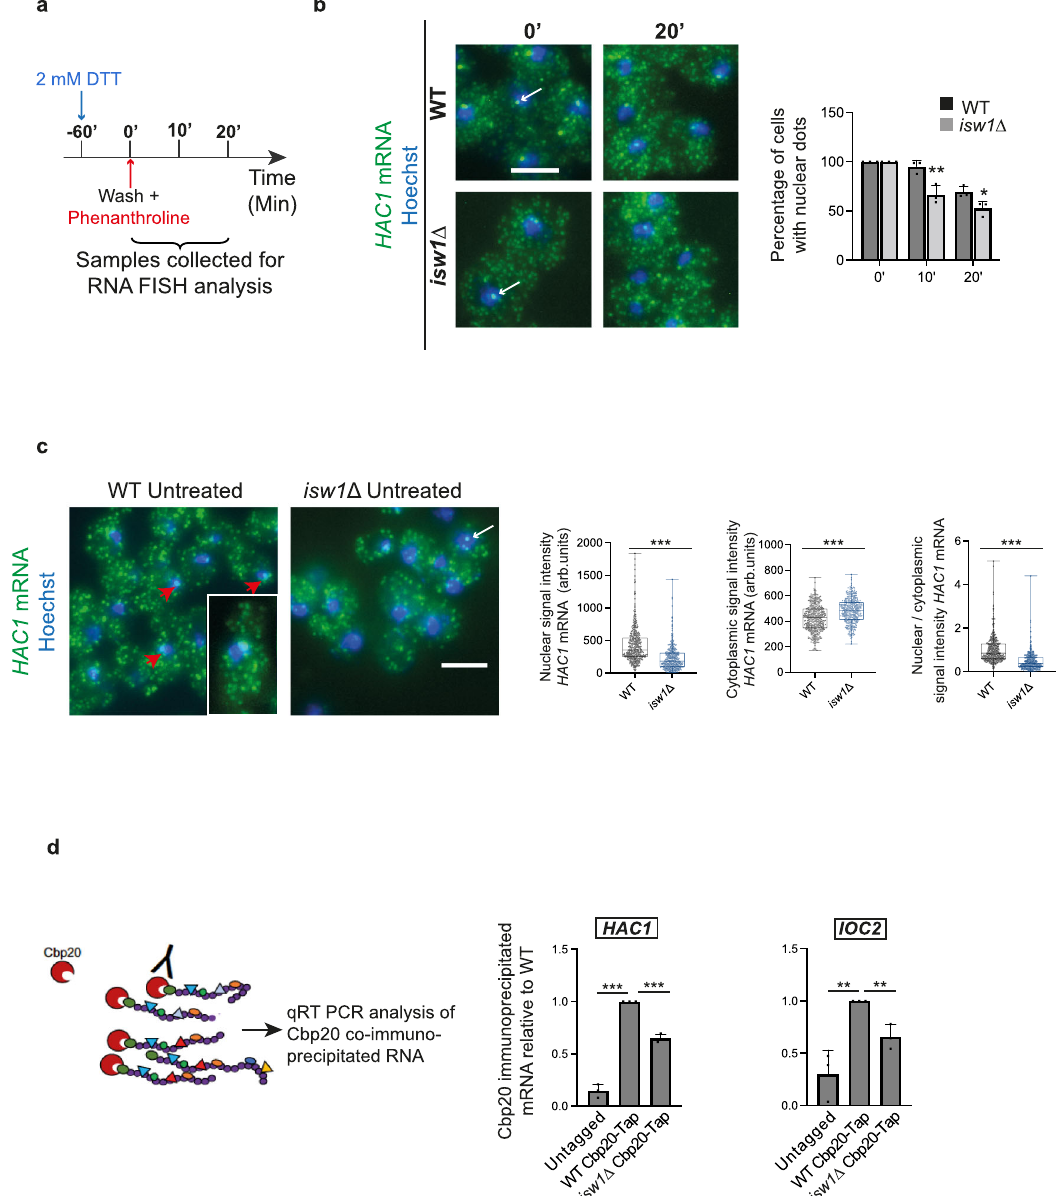
Fig. 4 | Isw1 is required for HAC1 mRNA nuclear retention. a Transcription shut- off experimental setting: Cells were treated with 2mM DTT for 2 H. At t =0, cells were washed and transcription was blocked by addition of 0.2mg/mL phenan- throline in fresh media. Samples were collected for analysis at t =0, 10 ’ and 20 ’ . b The subcellular localization of the HAC1 transcript after blocking transcription withphenanthrolinewasanalyzed inWTand isw1 Δ cellsbyFISHusingQuasar®670 - HAC1 probes. White arrows point to transcription sites. Scale bar, 5 μ m. For each time point, the percentage of cells showing a nuclear dot was scored. n =3 inde- pendent experiments, mean±s.d. Unpaired one-tail t -test ( p values relative to WT: 0.006583954and0.0194876for10 ’ and20 ’ respectively). c HAC1 mRNAsubcellular localization was analyzed by FISH using Quasar®670- HAC1 probes. White arrows point to transcription sites. Red arrows highlight nuclei with high- intensity HAC1 mRNAsignal(seealsoinset).Scalebar,5 μ m.NuclearandcytoplasmicQuasar®670- HAC1 signal intensities were measured in at least 200 cells. Unpaired two-tailed t -